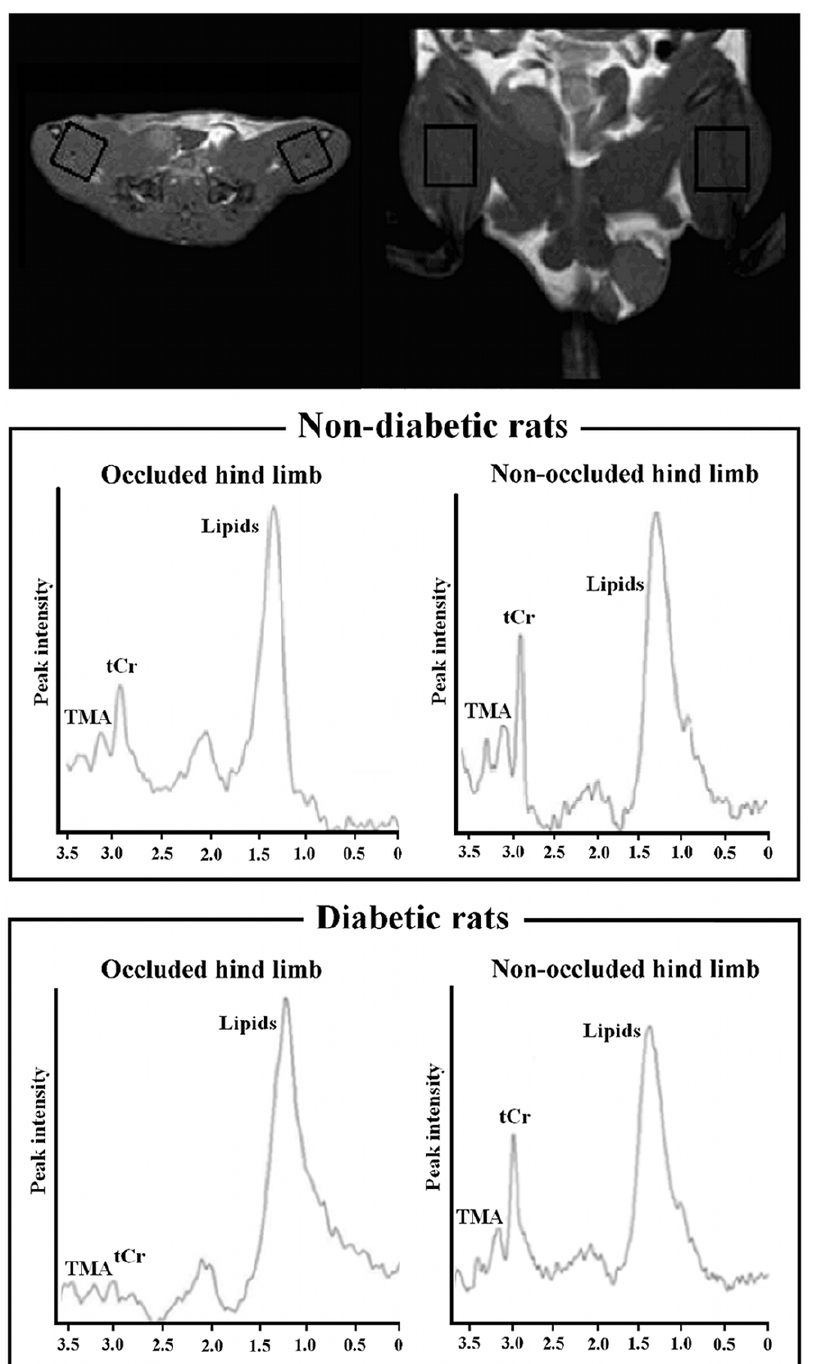
Figure 1. Representative 1 H-MR spectra. A voxel of 12 6 12 6 15 mm 3 was places on right ischemic and left non-ischemic limbs. The tCr peak was observed at 3.03 ppm, trimethyl ammonium-containing compounds (TMA) at 3.21 ppm and lipid resonance at 0.9–1.4 ppm. The smaller tCr peak observed in the ischemic limbs is indicative of ischemic damage in the muscle.